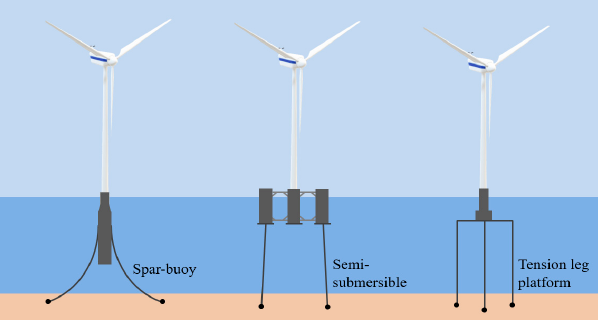
Figure 1. Three major types of floating offshore wind turbine (FOWT).